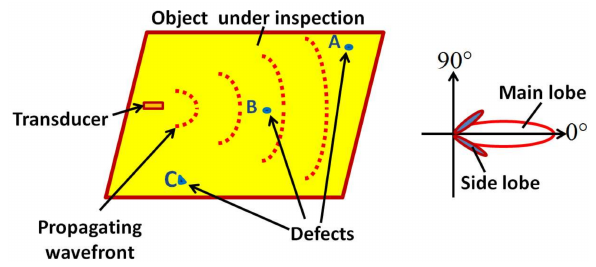
Figure 1. Explaining the directivity pattern of a directional transducer glued on the object under